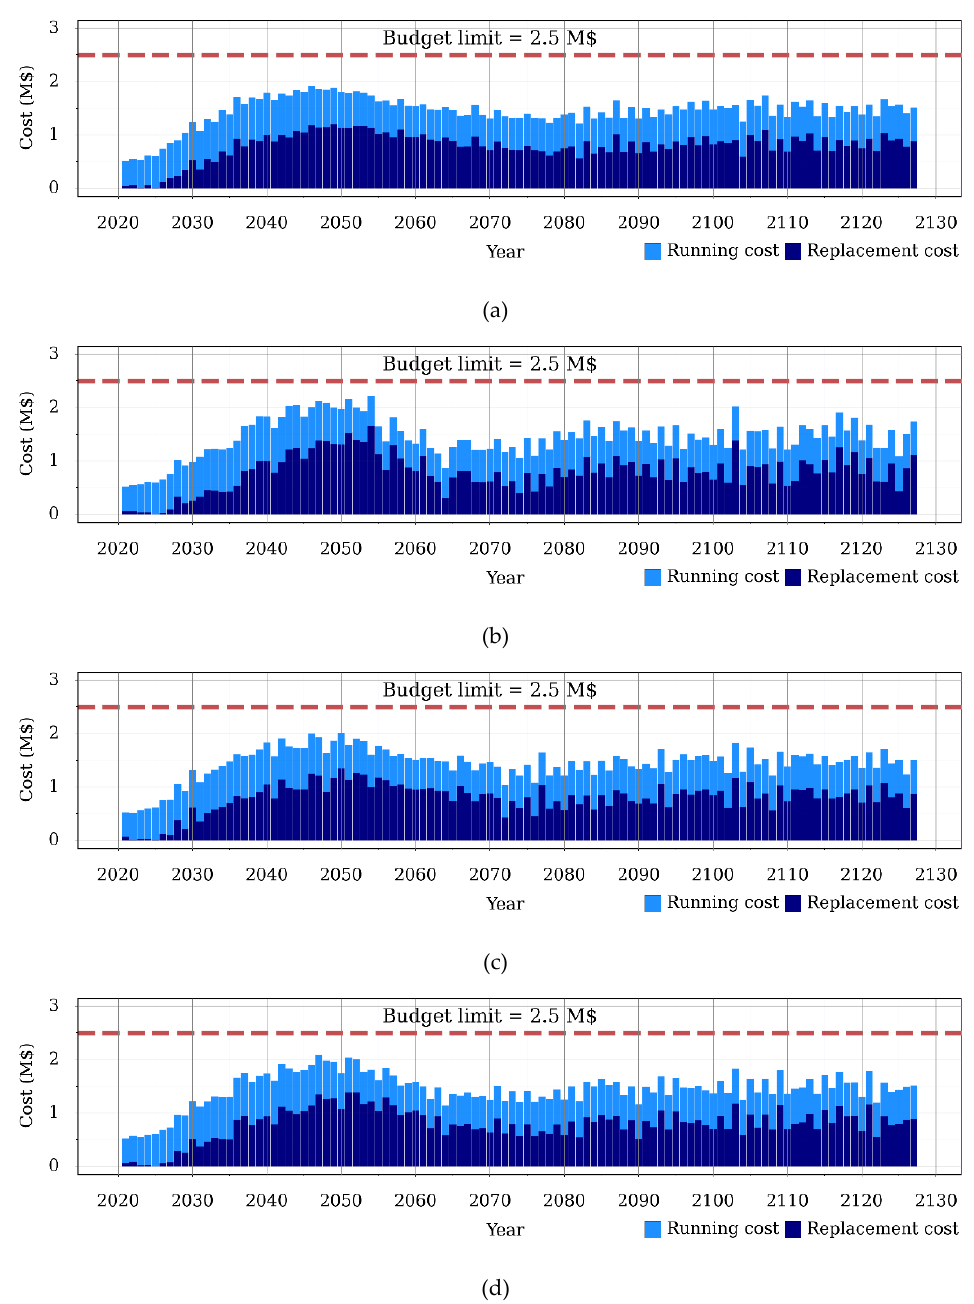
Figure 10. Future investment time series for Scenario 1: ( a ) Solution 1—min. SD of annual investment, ( b ) Solution 2—min. imposed LCC, ( c ) Solution 3—min. system age, and ( d ) Solution 4—knee-point.